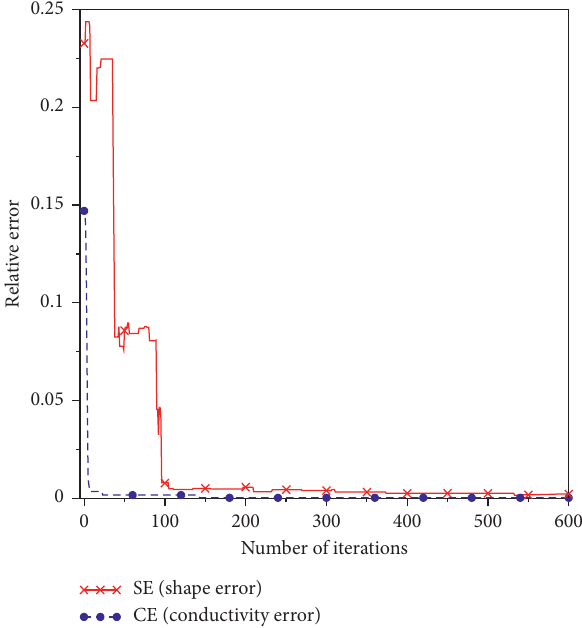
Figure 10: The relative shape and conductivity errors with respect to iteration loops of the whale optimization algorithm for the second